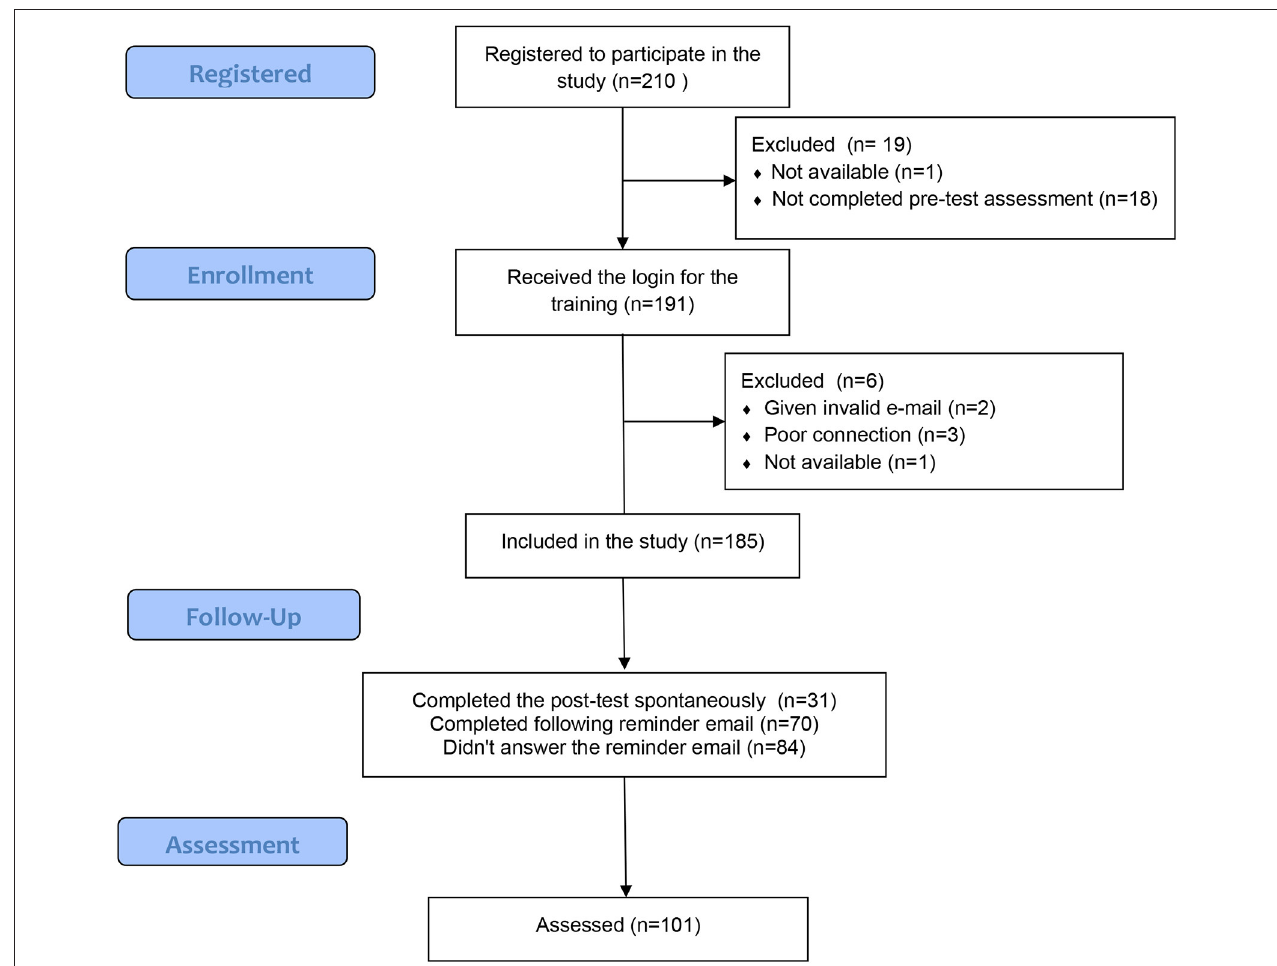
FIGURE 2 | Study flow chart.